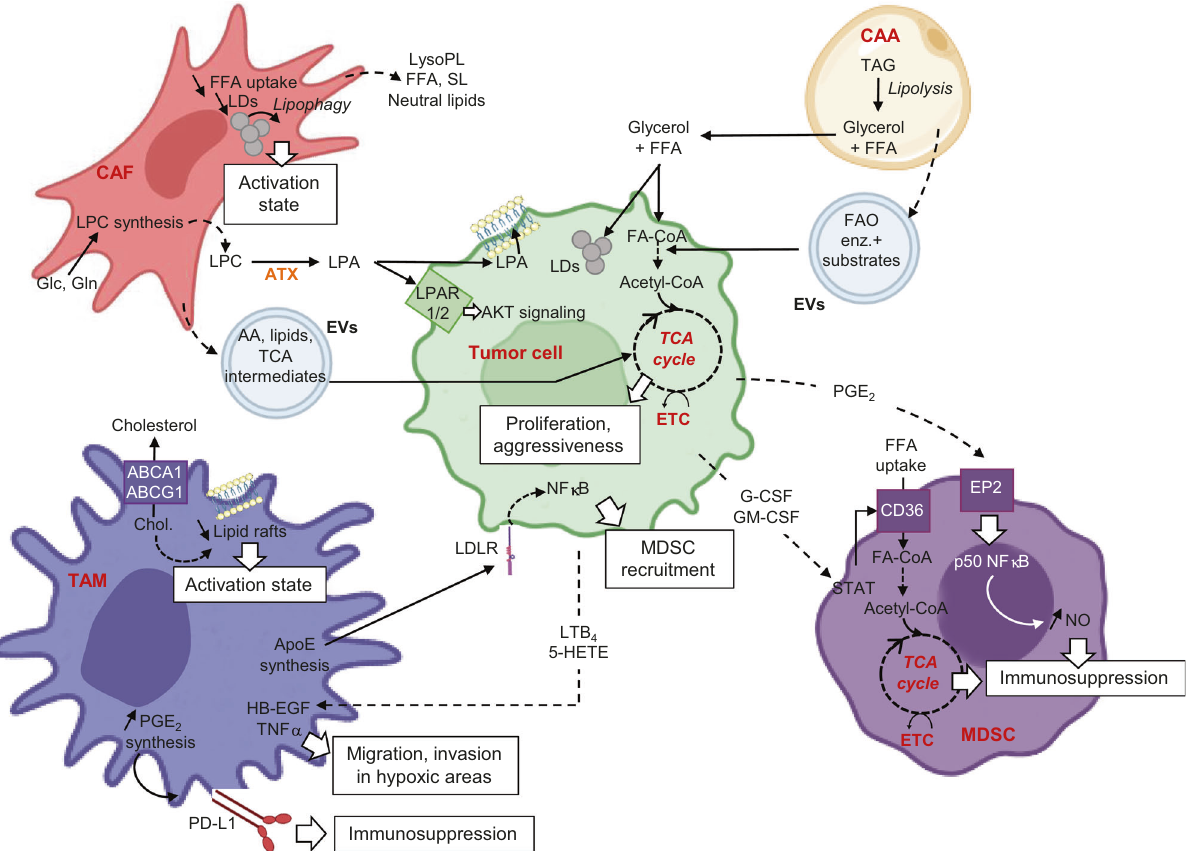
Fig. 3 Non-exhaustive scheme of lipid exchanges between tumor cells and tumor microenvironment (TME) cells and lipid reprogramming of stromal cells, that activate their pro-tumoral features. Cancer-associated fi broblasts (CAFs) take up free fatty acid (FFAs), produce various lipids and together with cancer-associated adipocytes (CAAs) produce extracellular vesicles (EVs) that reach tumor cells to supply them with metabolic intermediates and enzymatic arsenal to activate metabolic pathways, such as fatty acid oxidation (FAO). CAAs are the seat of activated lipolysis, and the resulting FFAs once released in the TME can be taken up by tumoral cells. In tumor-associated macrophages (TAMs), the decreased in lipid rafts domains, resulting from increased cholesterol ef fl ux, participate to TAMs activation. In these cells, prostaglandin E 2 (PGE 2 ) synthesis is also activated and contribute to the generation of an immunosuppressive tumor microenvironment. This latter is also promoted by myeloid-derived-suppressor cells (MDSCs), through the activation of FFA uptake and degradation and of the PGE 2 -PGE 2 receptor 2 subtype (EP2) signaling pathway. Tumor cells are the recipients of various lipid species released in the TME by TME cells and are the mediators of an immunosuppressive TME via their release of lipids and cytokines. TAG triacylglycerides, TCA tricarboxylic acid, LPA lysophosphatidic acid, LPC lysophosphatidylcholine, ATX autotaxin, ETC electron transport chain, FA-CoA fatty acyl-Coenzyme A, LD lipid droplets, Gln glutamine, Glc glucose, SL sphingolipids, AA amino acids, lysoPL lysophospholipids, G-CSF granulocyte-colony stimulating factor, GM-CSF granulocyte macrophage colony stimulating factor, NO nitrogen oxide, 5-HETE 5-dydroxyeicosatetraenoic acid, LTB 4 leukotriene B 4 , HB-EGF Heparin-binding EGF-like growth factor, TNF α tumor necrosis factor α , LDLR low-density lipoprotein receptor, PD-L1 programmed cell death-ligand 1, ABCA1 ATP Binding Cassette Subfamily A Member 1, ABCG1 ATP Binding Cassette Subfamily G Member 1. Indirect reaction is illustrated by dotted arrow and direct reaction by solid